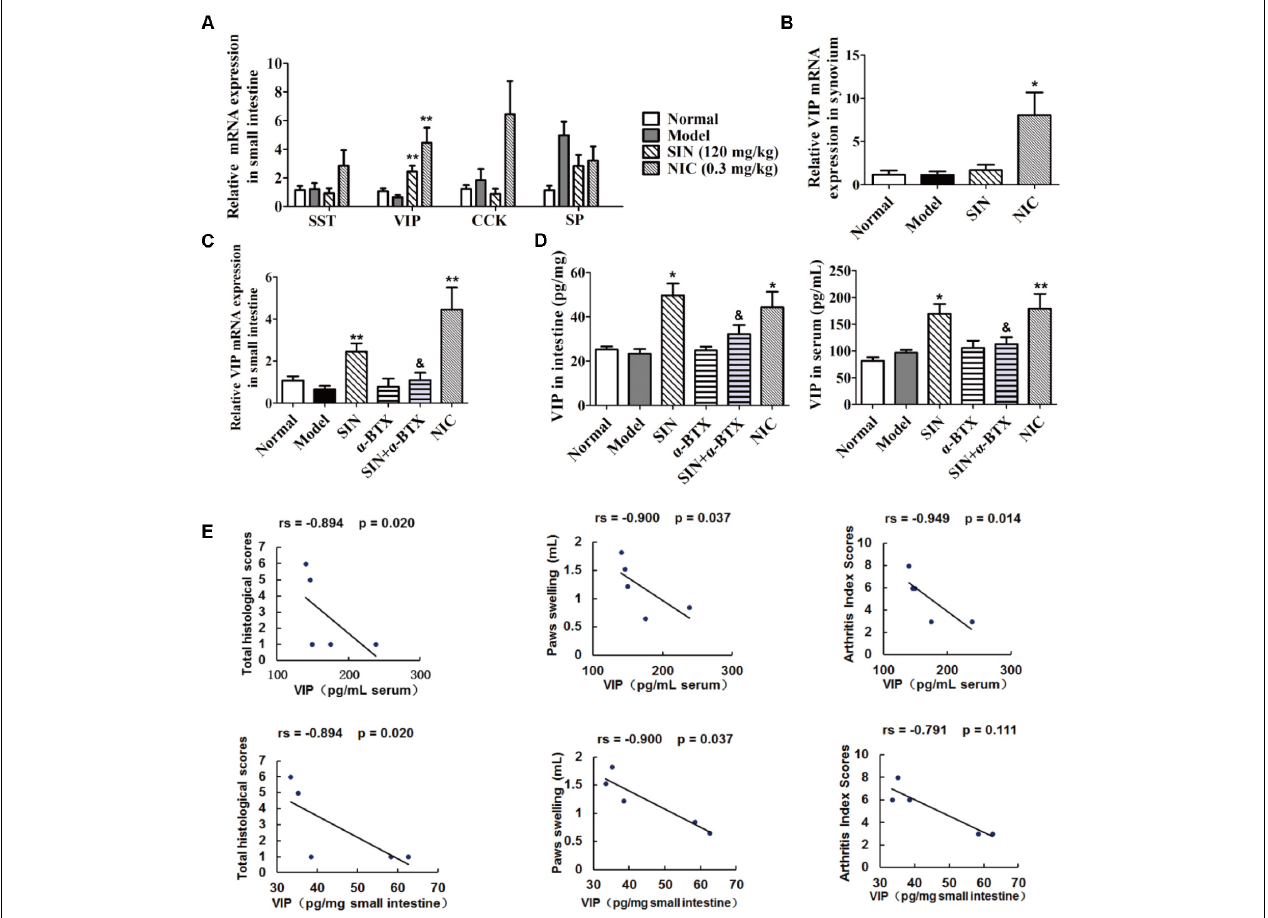
FIGURE 4 | Influence of sinomenine (SIN) on neuropeptides in serum, small intestine and synovium of CIA rats. Rats were intragastrically administered with SIN and intraperitoneally administered with α -bungarotoxin ( α -BTX) or nicotine (NIC) from day 14 to day 28. α -BTX was administered 30 min before the administration of vehicle or SIN. (A) The mRNA expressions of SST, VIP, CCK, and substance P (SP) in small intestine were measured by quantitative PCR assay. (B) The mRNA expression of VIP in synovium was measured by quantitative PCR assay. (C) The mRNA expression of VIP in small intestine was measured by quantitative PCR assay. (D) The level of VIP in small intestines and sera were determined by ELISA. (E) Correlations of intestinal/serum level of VIP with histological scores, paws swelling, or arthritis index scores were evaluated by spearman bivariate correlation analysis. Rs, Spearman’s rank correlation coefficient. P -values less than 0.05 were considered as significant difference. The relative expressions of genes measured by quantitative PCR assay were normalized to that of β -actin. Data were expressed as means ± SEM, n = 5. ∗ P < 0.05 and ∗∗ P < 0.01 versus Model; & P < 0.05 versus